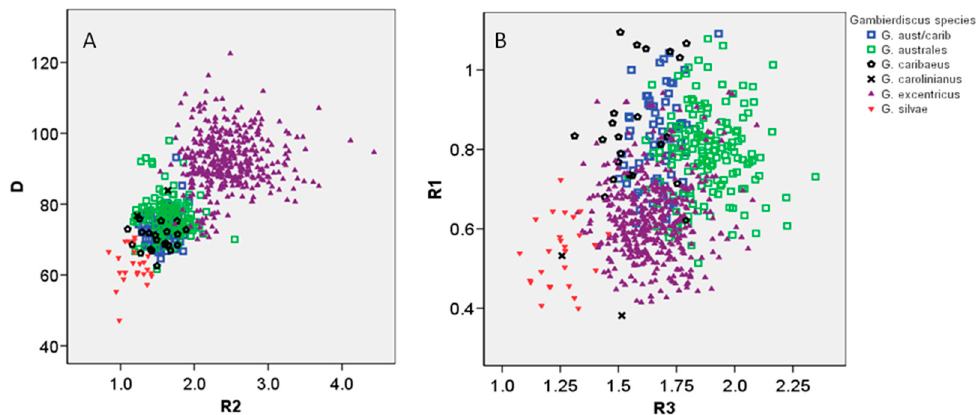
Figure 5. Scatterplots of morphological parameters observed in Gambierdiscus spp. cells from Cotillo and Playitas stations from Fuerteventura Island. ( A ) D against R2 and ( B ) R1 against R3.